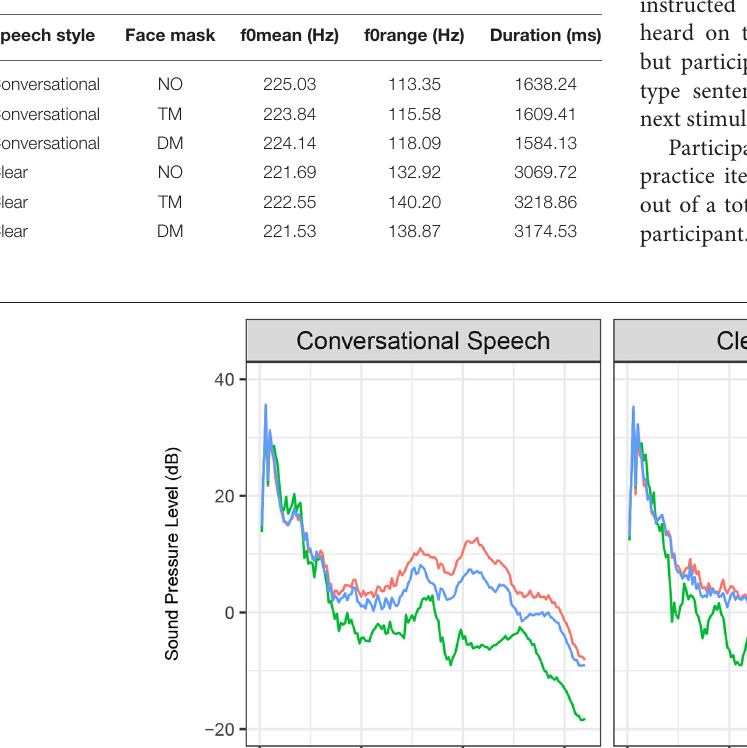
Frontiers in Psychology |